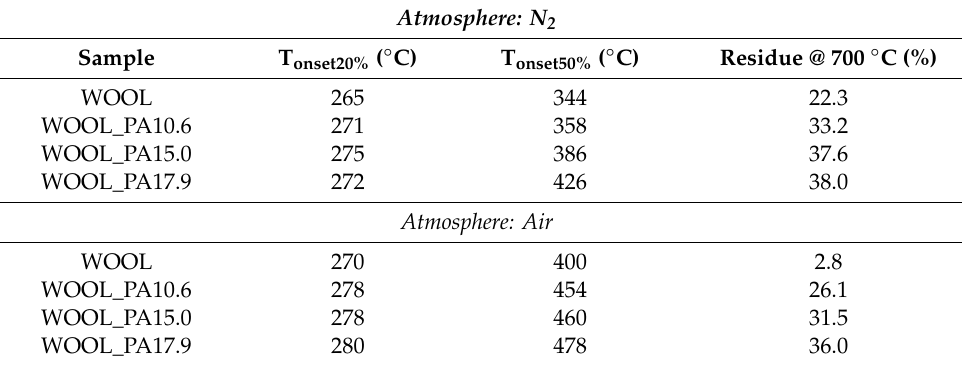
Table 13. Results from the thermogravimetric analyses for untreated (WOOL) and PA-treated (WOOL_PA) wool fabrics.